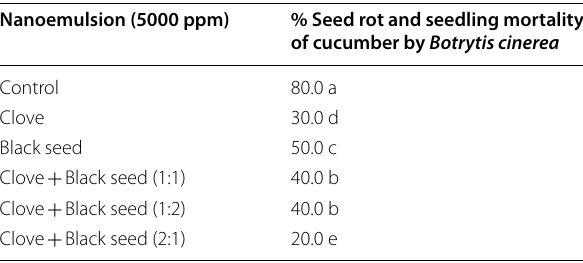
Table 4 Effect of nanoemulsions formulations of clove and black seed oils on seed rot and seedling mortality of cucumber caused by B. cinerea